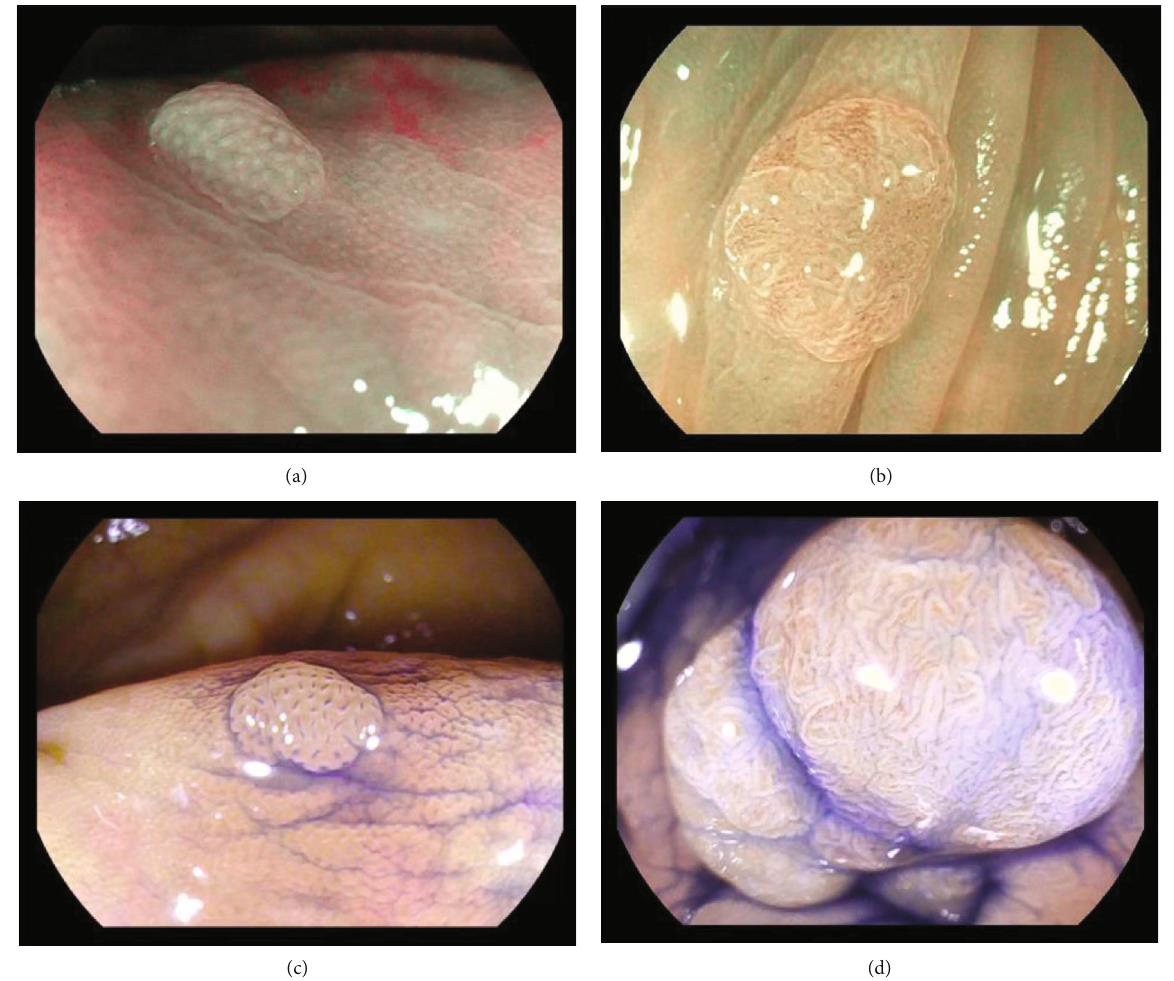
Figure 1: Endoscopic images in the magnifying mode: (a) nonneoplastic polyps (JNET type 1); (b) neoplastic polyps (JNET type 2A); (c) nonneoplastic polyps (pit pattern types I); (d) neoplastic polyps (pit pattern type IV).